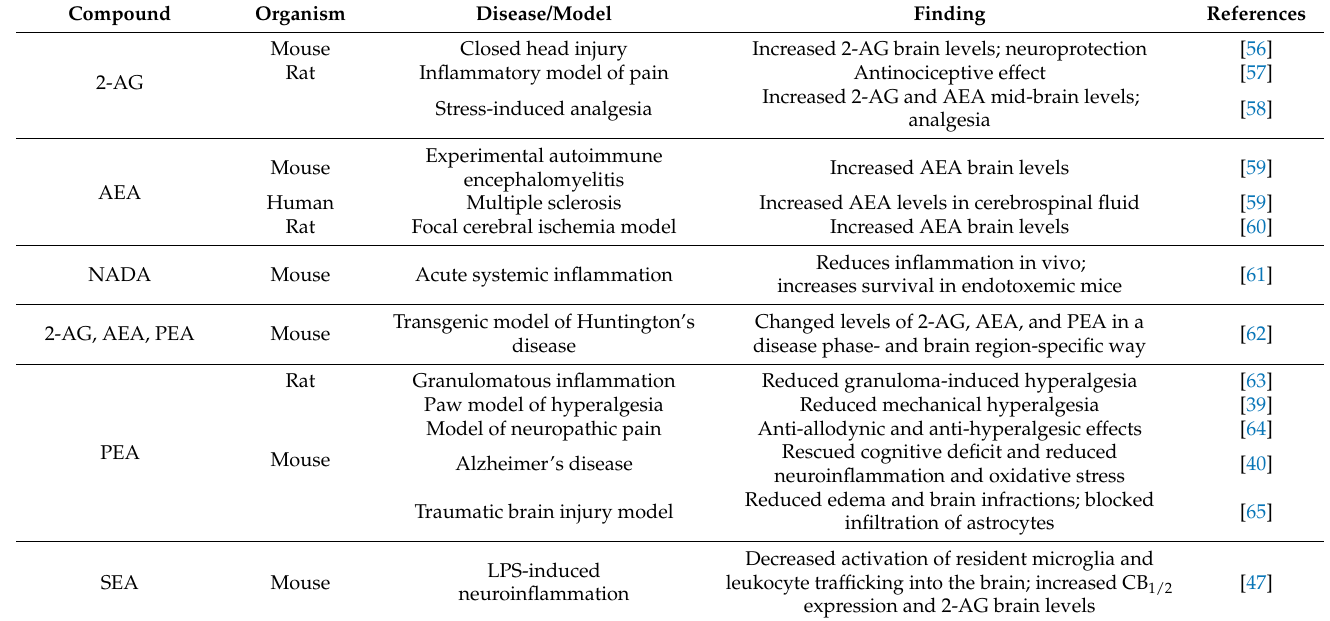
Table 2. The profiles and activity of eCBs and their congeners in pathological conditions of the CNS.